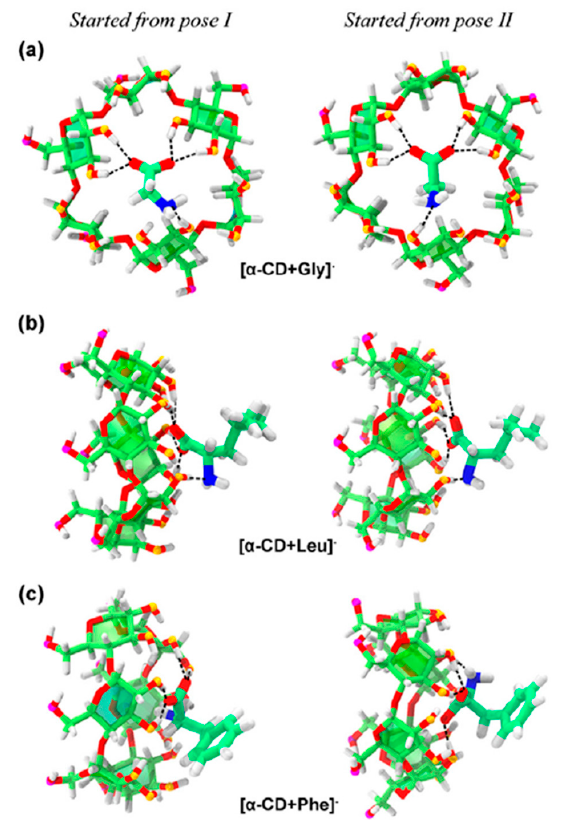
Figure 11. Structures of ( a ) [ α -CD + Gly] − , ( b ) [ α -CD + Leu] − , and ( c ) [ α -CD + Phe] − complexes obtained via MD simulations. Reprinted from Reference [26], Copyright (2018), with permission from Elsevier.